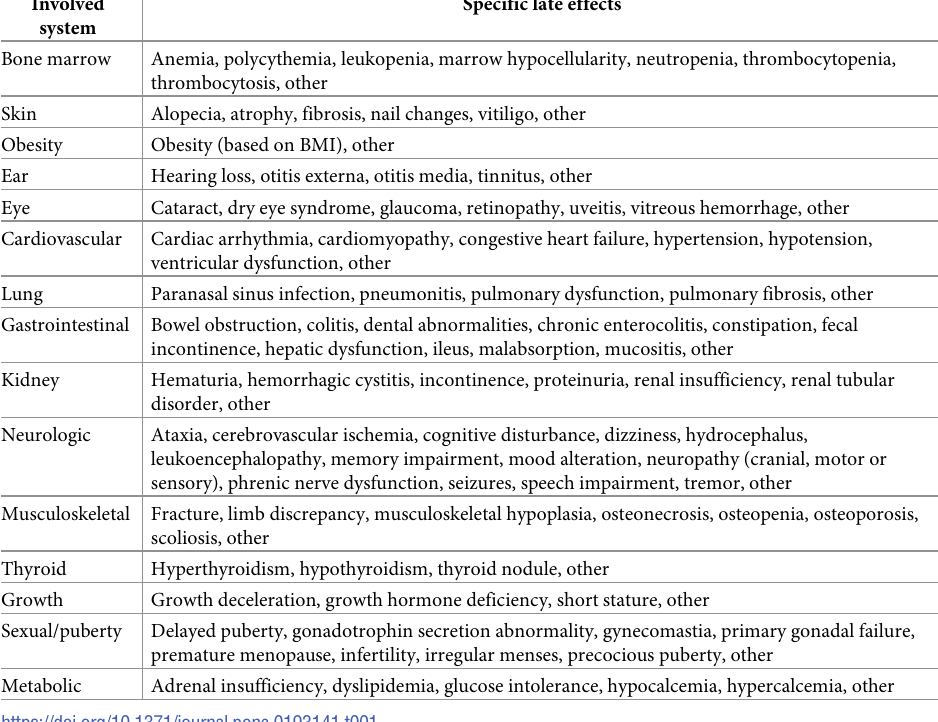
Table 1. Categorization of specific late effects. Involved